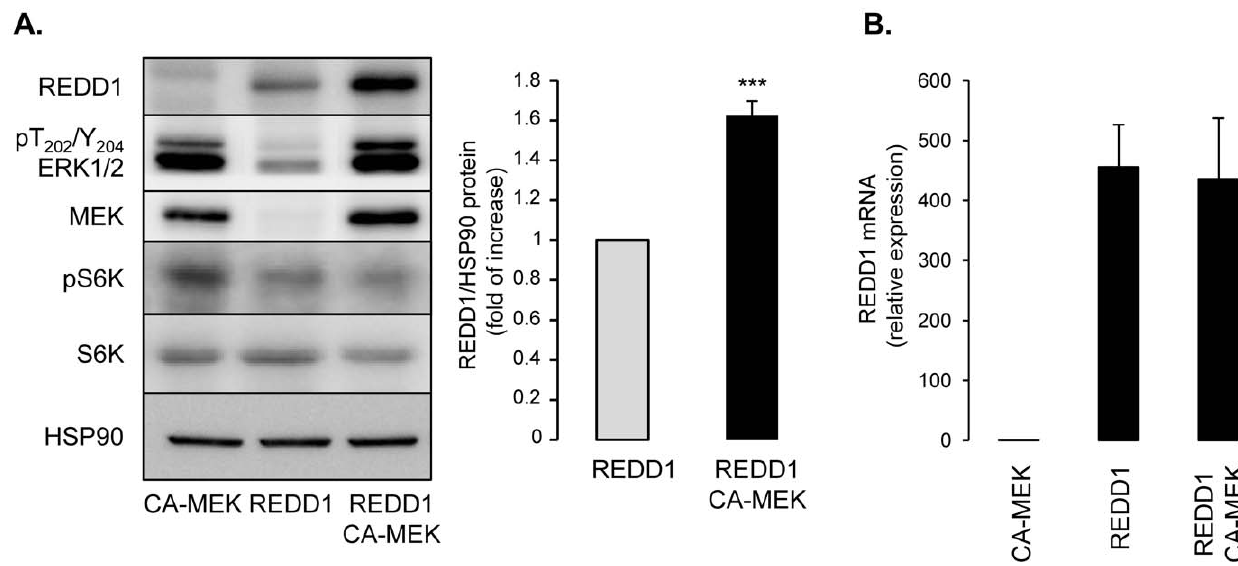
Figure 3. Expression of constitutive active MEK increases REDD1 protein level in HEK-293 epithelial cells. HEK-293 cells were transfected with plasmids encoding for constitutive form of MEK (CA-MEK), REDD1 or both plasmids. (A) Proteins were analyzed by immunoblots using indicated antibodies. REDD1 protein level is expressed compared to HSP90 expression and quantification of seven independent experiments is shown (***p , 0.001). (B) REDD1 mRNA level was determined by quantitative RT-PCR.